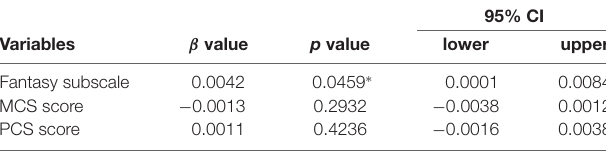
TABLE 4 | Multiple regression analysis using the average beta value in the striatum cluster as the dependent variable in the MRI session.